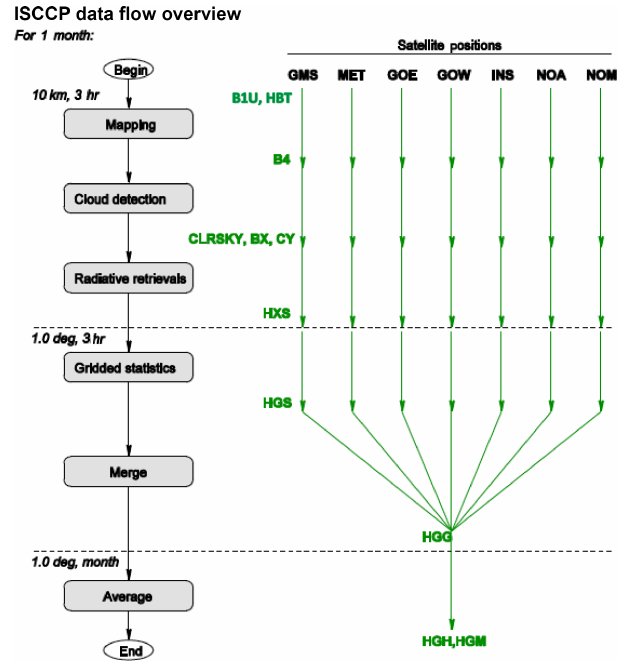
Figure 2. Illustration of ISCCP production with satellite processing streams defined for five geostationary data streams (GMS at 140 ◦ E, MET at 0 ◦ , GOE at 75 ◦ W, GOW at 135 ◦ W and INS at ∼ 63 ◦ E) and two polar orbiter streams (NOM and NOA). The left side of the image shows important steps in ISCCP H-series data processing that feed into the various H-series